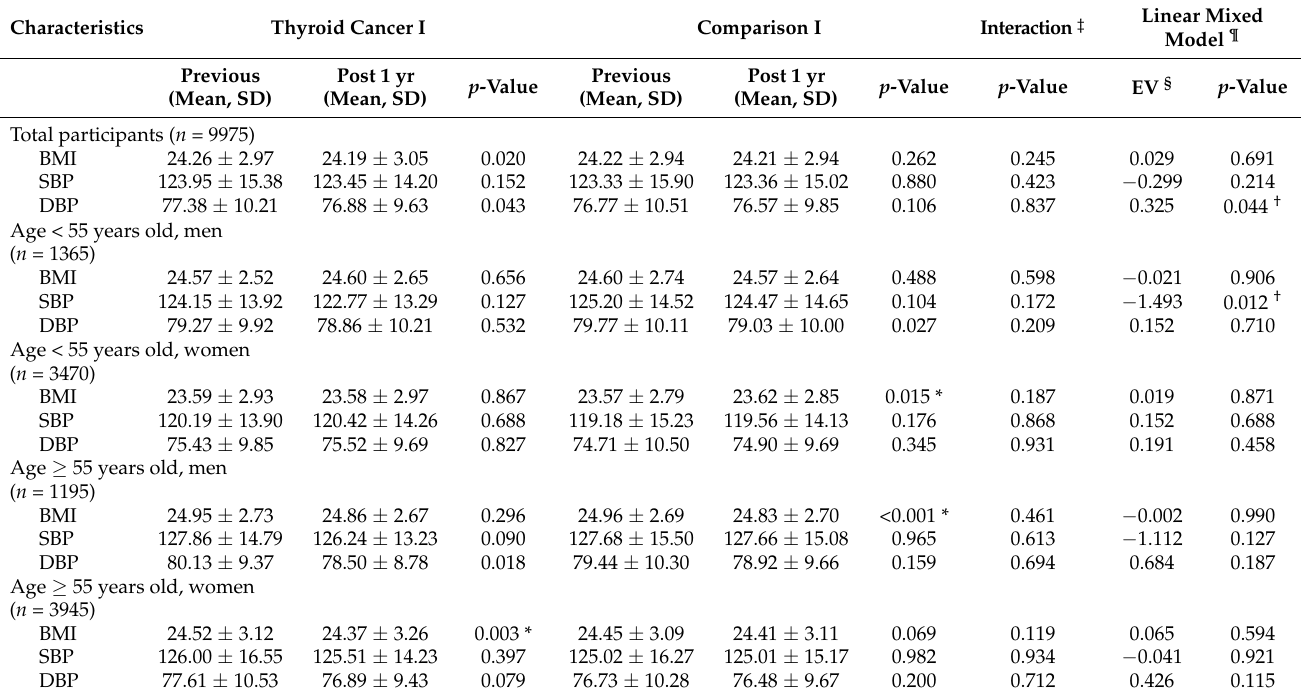
Table 2. Difference in mean values of BMI and blood pressure between pre and 1-year post thyroid cancer in study I according to age and sex.